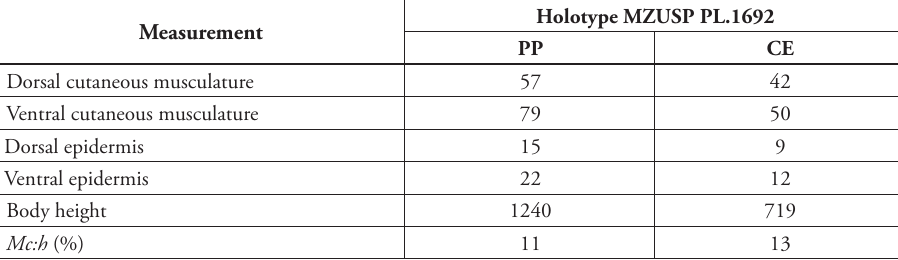
Table 6. Body height and cutaneous musculature in the median region of a transversal section of the pre-pharyngeal (PP) and cephalic (CE) regions, in micrometres, and ratio of the thickness of cutaneous musculature to the height of the body (mc:h index) of the holotype of Cratera aureomaculata sp.